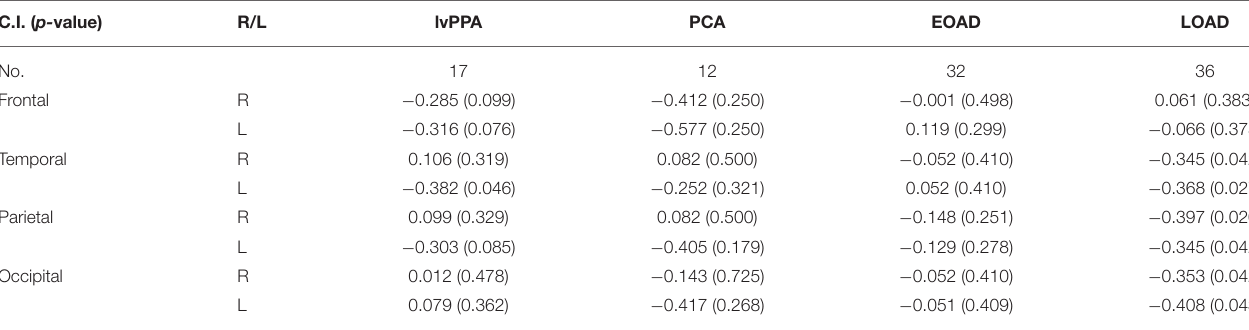
TABLE 6 | Correlation between the levels of CBF volumes and the number of lobar CMBs in the four subtypes of AD patients. C.I. ( p- value)